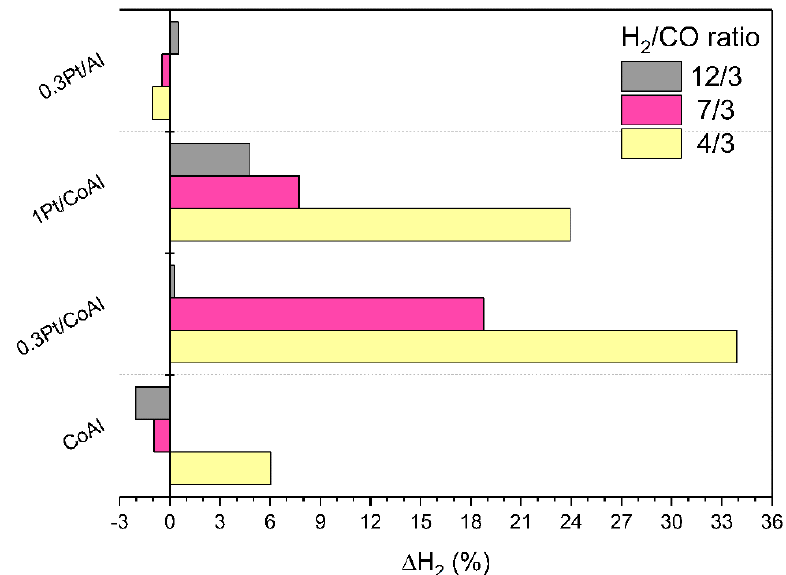
Figure 8. Net hydrogen variation in WGS reaction feeding H 2 at 260 °C/50 bar. Reaction conditions: W cat = 0.2 g, F H2O = 0.04 mL/min, F CO = 3.5 mL/min.